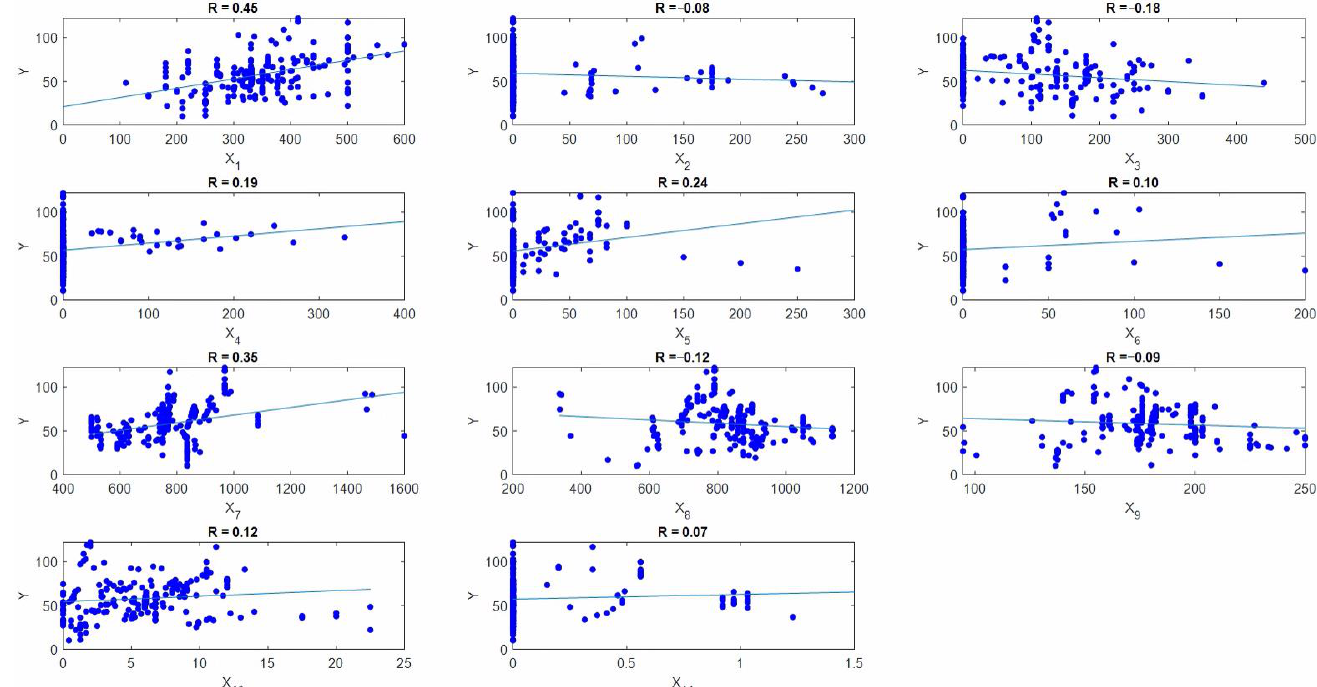
Figure 1. Scatter plots of variables in Dataset 1.